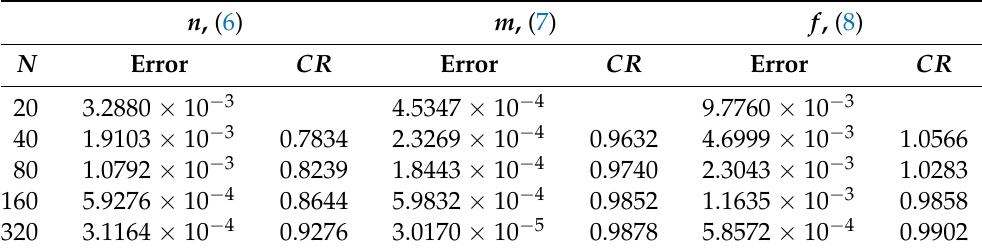
Table 4. Errors in conservation and evolution laws (6) and (8), T = 3, Example